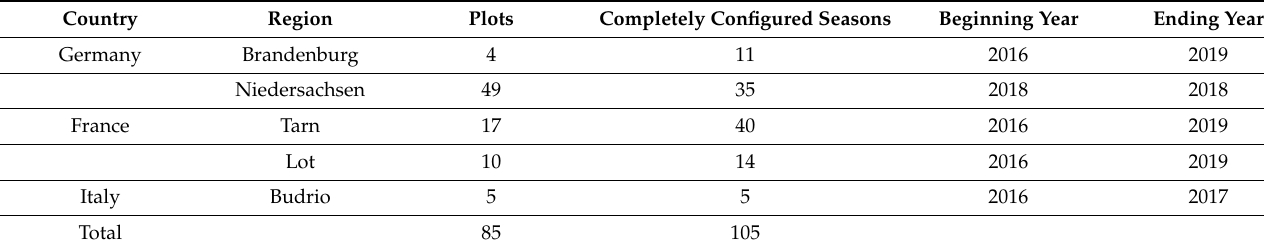
Table A1. The plot and seasons of the